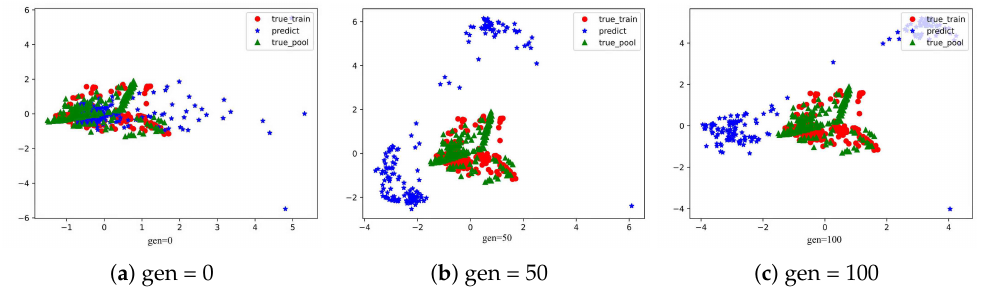
Figure 9. Population evolution of DRBM-Social-IGA based on the DRBM-Social surrogate model.